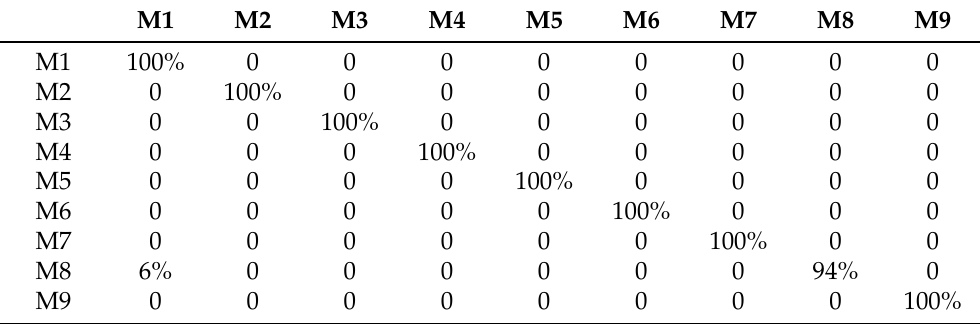
Table 6. Confusion matrix for the proposed method.